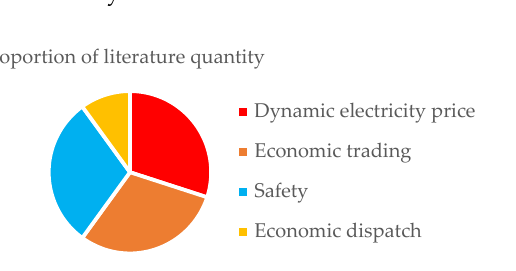
Figure 2. Application situation of blockchain in power dispatch.